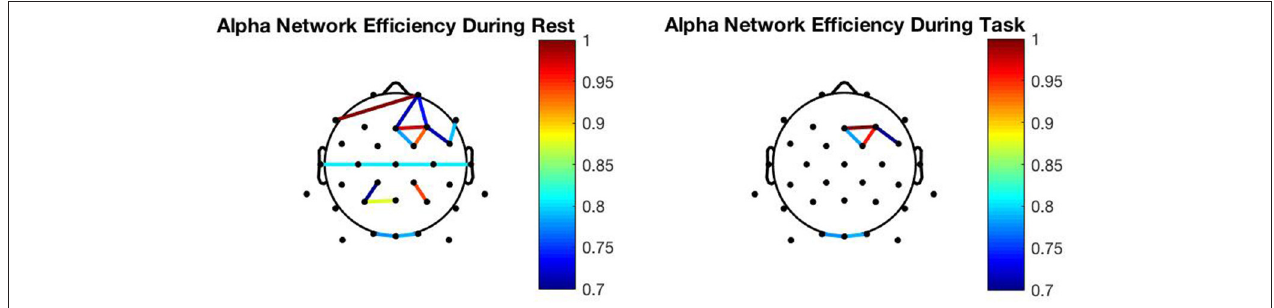
FIGURE 4 | Network changes: Resting alpha network connectivity (Left) Alpha network connectivity during action observation (Right). To be noted, the graphs presented are from the 10th subject.